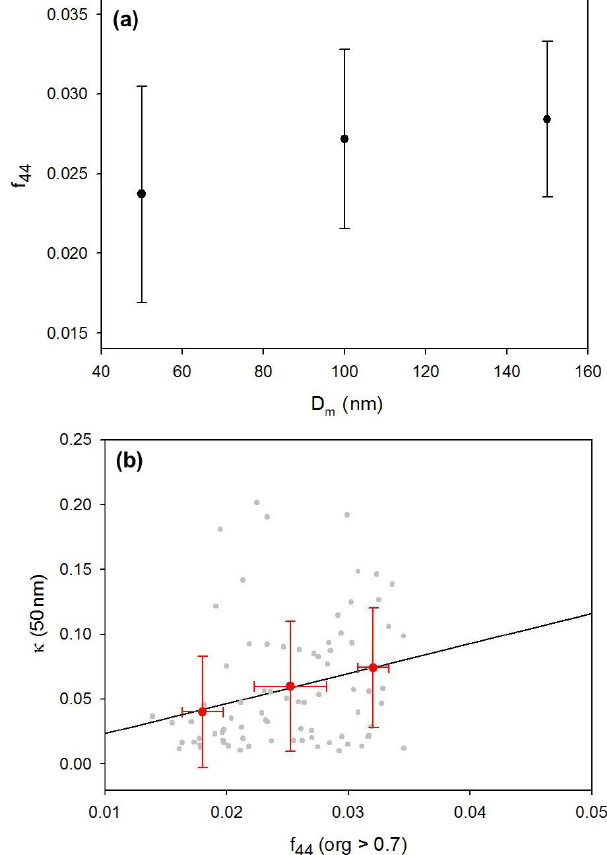
Figure 8. (a) Size-resolved f 44 and (b) relationship between f 44 and κ values ( κ HTDMA ) for 50nm particles (the f 44 values are only used when the organic volume fraction is higher than 0.7). Red dots and bars indicate average and standard deviations for each of the 0.01 interval